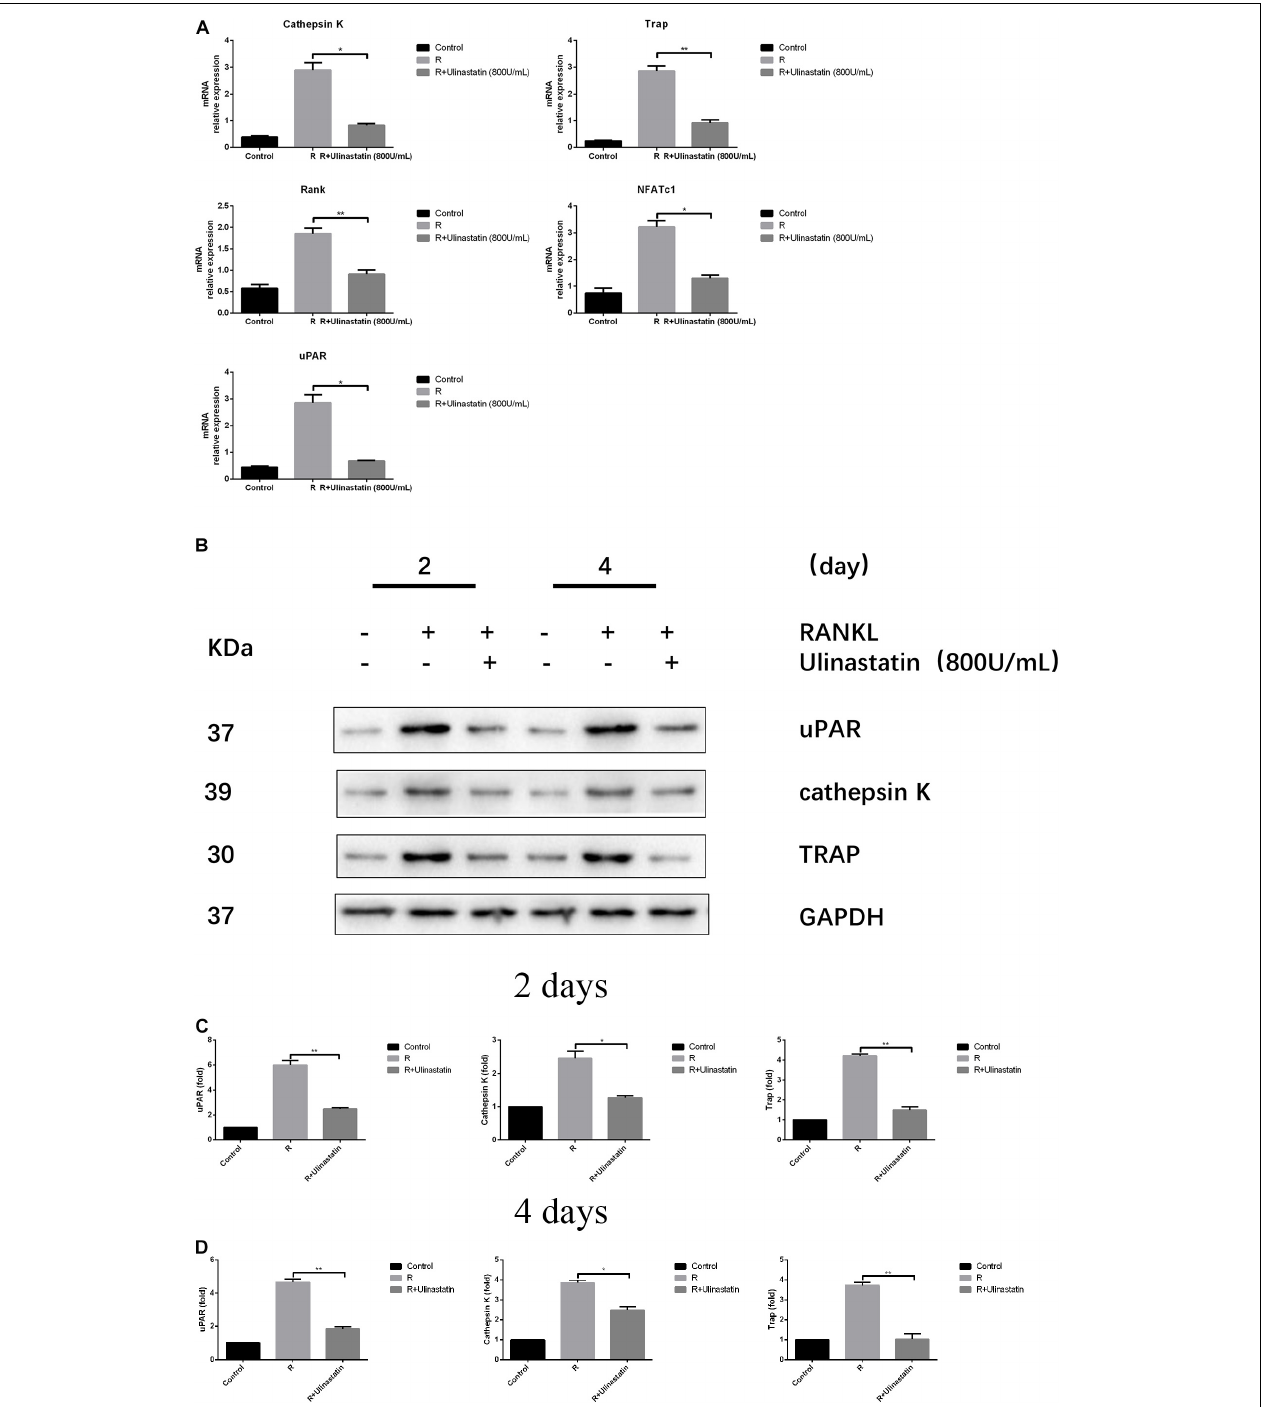
FIGURE 5 | Ulinastatin reduces the expression of uPAR, NFATc1 and osteoclast marker genes induced by RANKL. C represents control group, R represents RANKL group, R + ulinastatin represents RANKL + 800 units/mL ulinastatin group. (A) Ulinastatin reduces RANKL-induced mRNA expression of cathepsin K, Trap, Rank, NFATc1, and uPAR. BMMs were cultured with M-CSF (30 ng/mL) and RANKL (100 ng/mL), and treated with or without ulinastatin (800 units/mL) for 4 days. mRNA expression was detected by qRT-PCR. The qRT-PCR experiments have been repeated with different RNA preparations for 3 times independently. Data are represented as mean ± SD . ∗ P < 0.05 and ∗∗ P < 0.01. (B,C,D) Ulinastatin reduces RANKL-induced protein expression of uPAR, cathepsin K and Trap. BMMs were cultured with M-CSF (30 ng/mL) and RANKL (100 ng/mL), and treated with or without ulinastatin (800 units/mL) for 2 or 4 days. Protein expression levels of uPAR, cathepsin K and Trap were examined by western blotting at the indicated times. The amount of loaded protein was 25 µ g. The experiment was performed three times independently and GAPDH was used as a loading control. ∗ P < 0.05, ∗∗ P < 0.01 versus RANKL group.